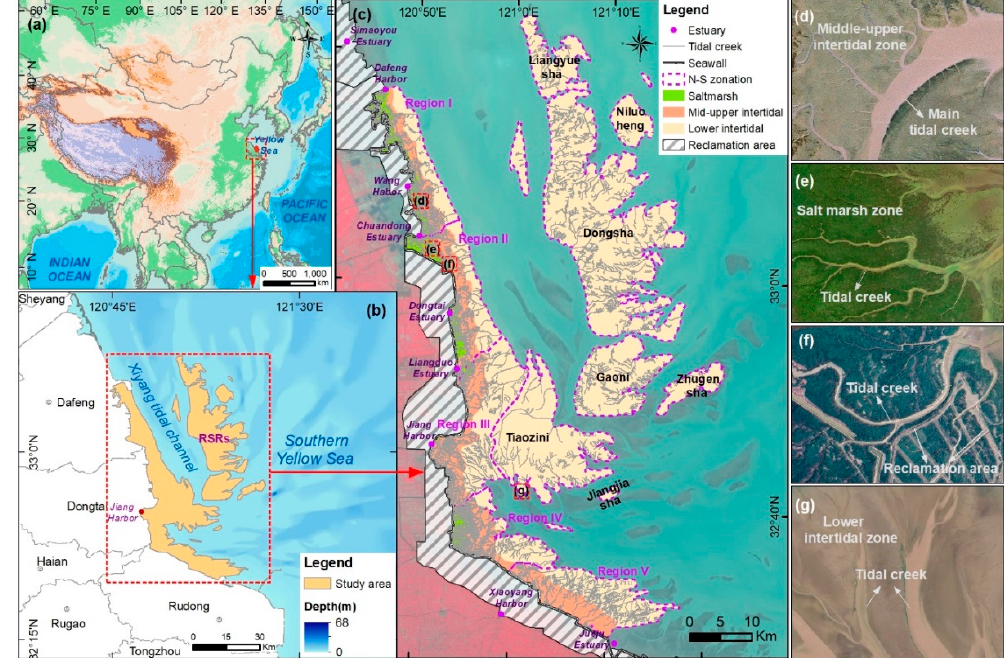
Figure 1. Location and zonation of the Jiangsu central coastal region. ( a ) Location of the study area. ( b ) Enlargement of the red dotted rectangle in ( a ). The orange area indicates the specific scope of the study area. ( c ) Spatial distribution and zonation of tidal creeks. ( d – g ) Different types of tidal creeks derived from high-resolution Google Earth images: ( d ) main tidal creek in the middle-upper intertidal zone, ( e ) tributary tidal creeks in the salt marsh zone, ( f ) tidal creeks close to a reclamation area, ( g ) tidal creeks developed in the lower intertidal zone.